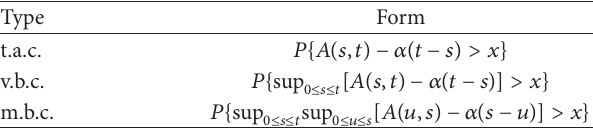
Table 1: Stochastic arrival curves. Type